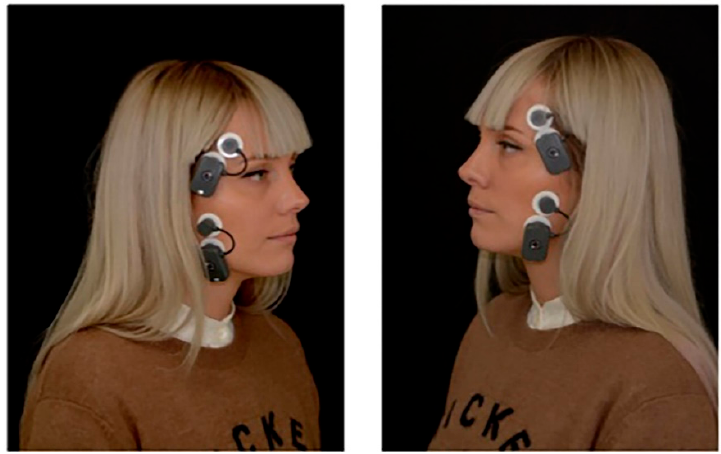
Figure 1. Image of a surface electromyographic exam (Teethan, BTS S.p.A., Garbagnate Milanese, Milan, Italy).